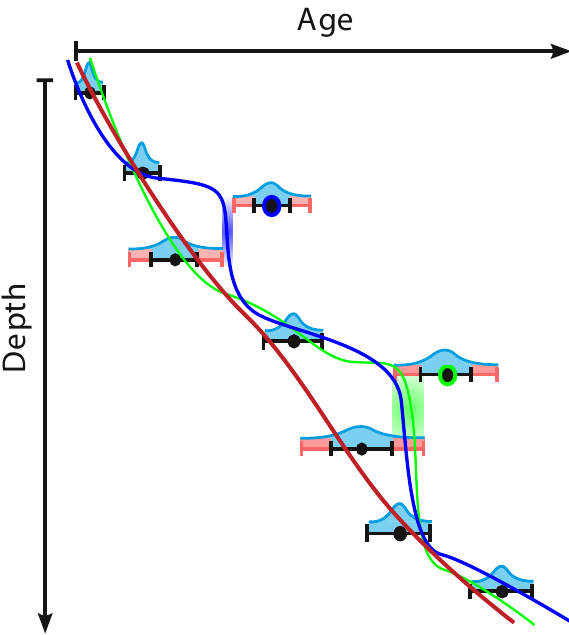
Fig. 2. Classifying age reversals: a non-tractable reversal (point marked in blue) has its lower 2 σ margin outside the upper 2 σ mar- gin of the subsequent point in the dating table. Thus, the probability of finding a stratigraphically correct depth-age curve (such as the blue curve) is very low and tending toward zero, even though it is possible in principle. On the other hand, a tractable reversal (point marked in green) has non-zero overlap of the 2 σ margin with that of the next point, making it computationally feasible to find a cor- rect physically relevant depth-age curve (e.g., the green curve). The ends of 2 σ error margins for the relevant points are marked in light red. The dark red line represents the possibly most likely depth-age curve if both outliers are eliminated. In this case, the age model reaches a very homogeneous growth rate, which might reflect the most realistic growth